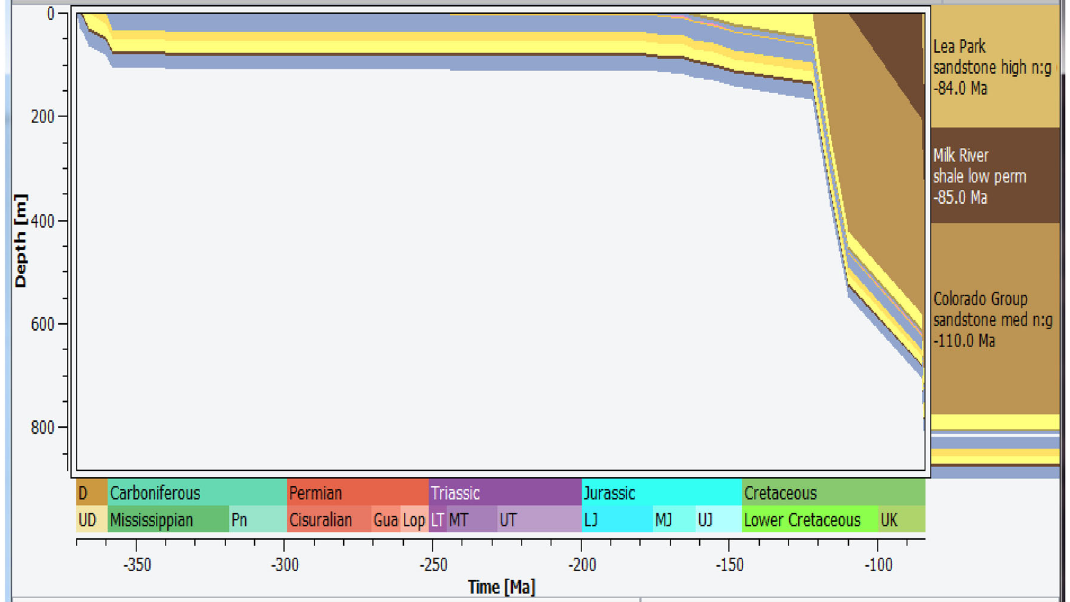
Fig. 8 Geohistory plot (burial history)—output from 1D basin modeling